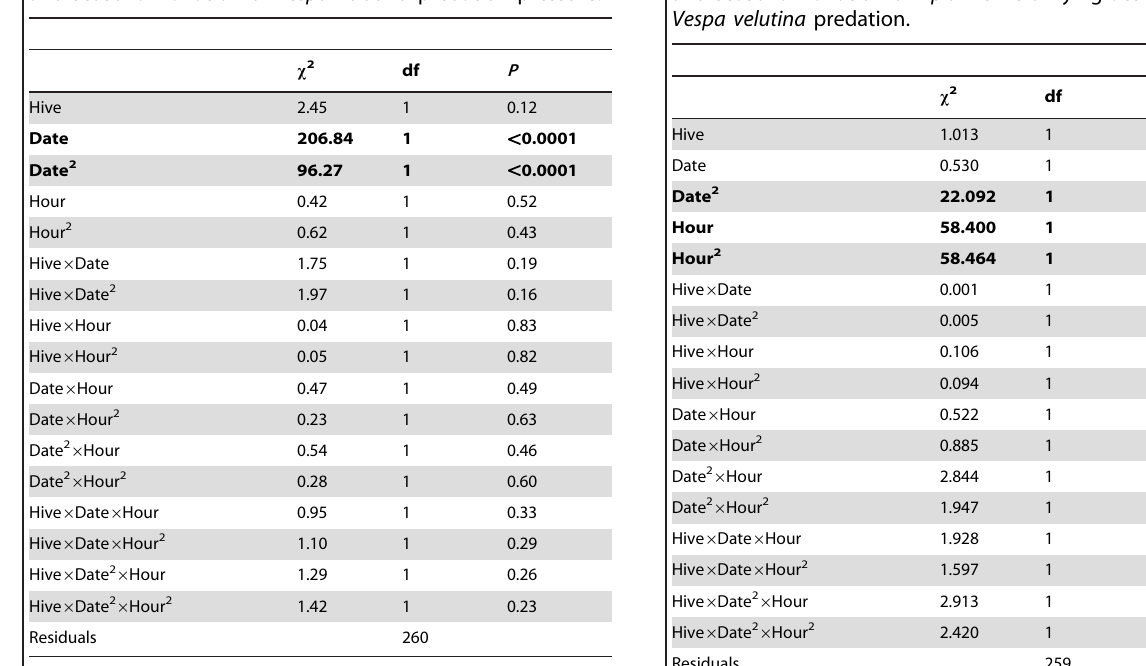
Table 1. Summary of the GLM (Poisson family) of the diurnal and seasonal variation of Vespa velutina predation pressure.